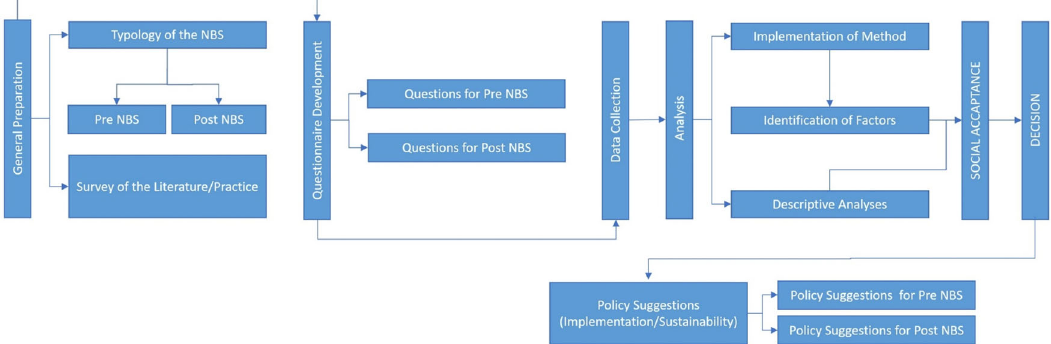
Fig. 2 A replicable and comparable decision-making framework for NBS. The framework illustrates how social acceptance is incorporated into the decision-making process and allows replicable and comparable